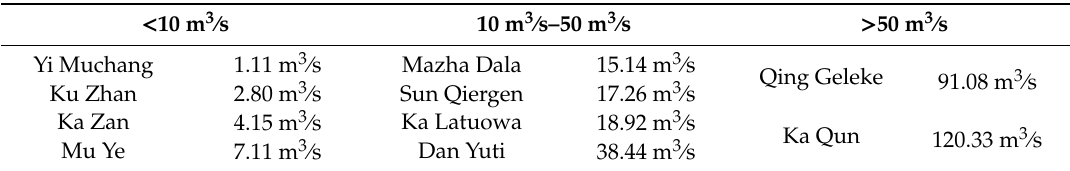
Table 7. Measured discharge of ten